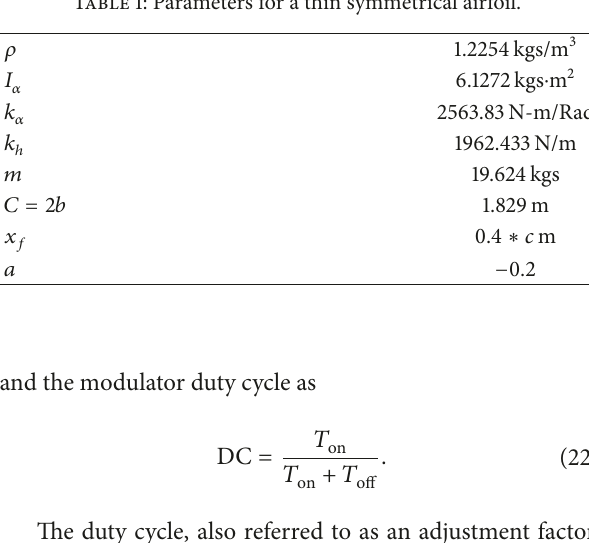
Table 1: Parameters for a thin symmetrical